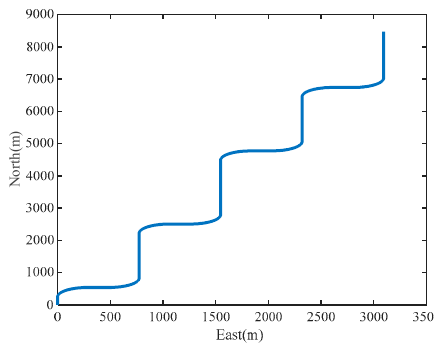
Figure 6. The trajectory of the carrier.